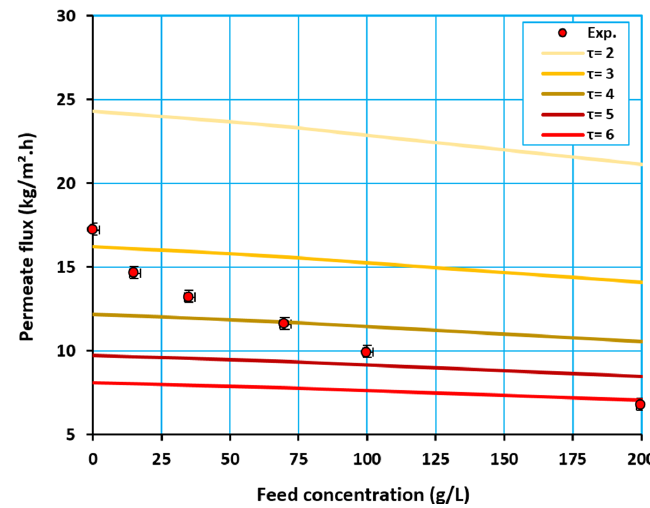
Figure 11. Effect of the feed concentration on the permeate fluxes at various tortuosity levels predicted by the model with the experimental data at a feed temperature of 60 °C and a feed flow rate of 1.07 L/min.